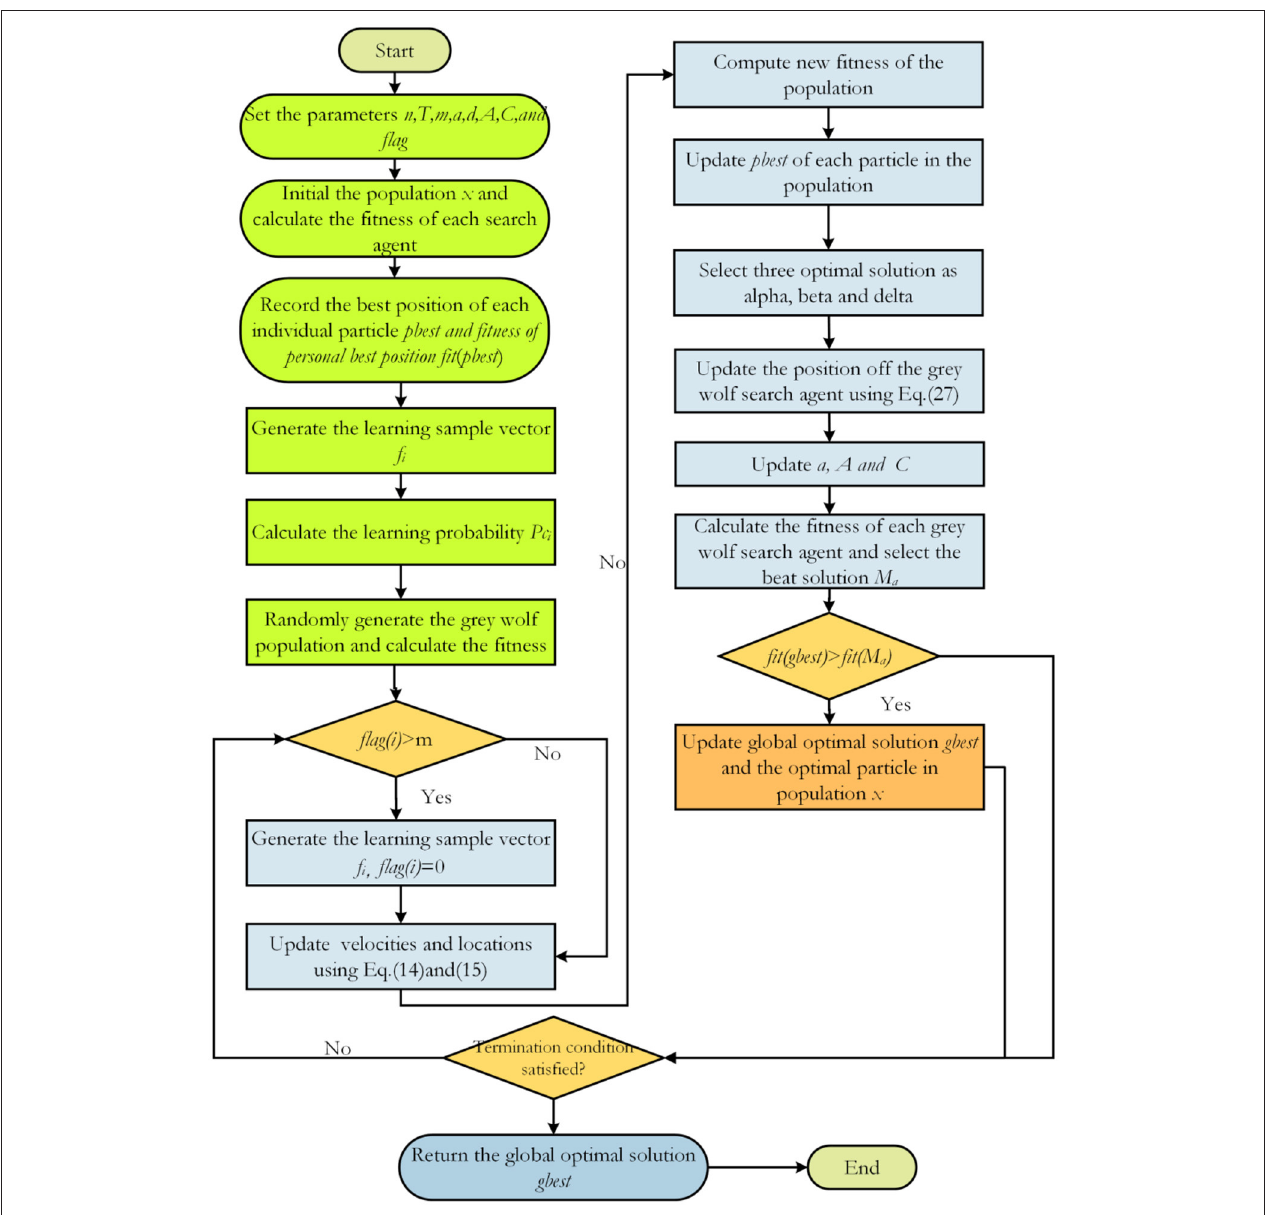
FIGURE 3 | Flowchart of